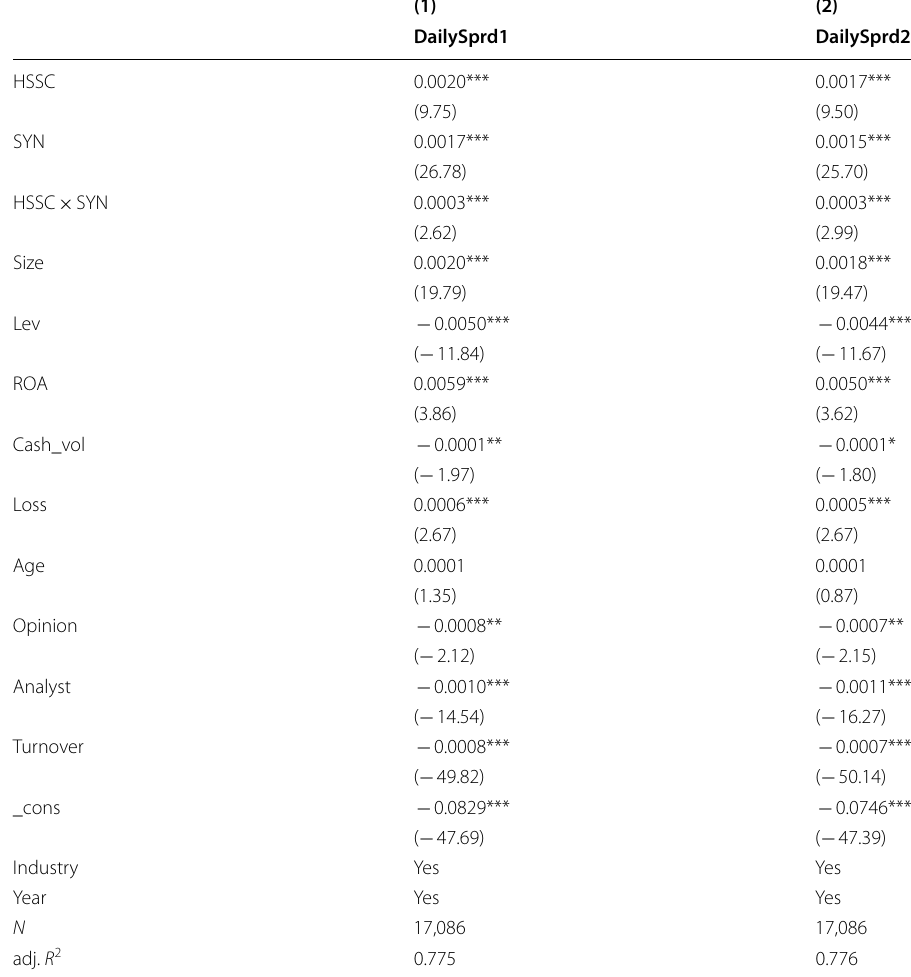
Table 3 Stock connect and market efficiency: the role of stock price informational